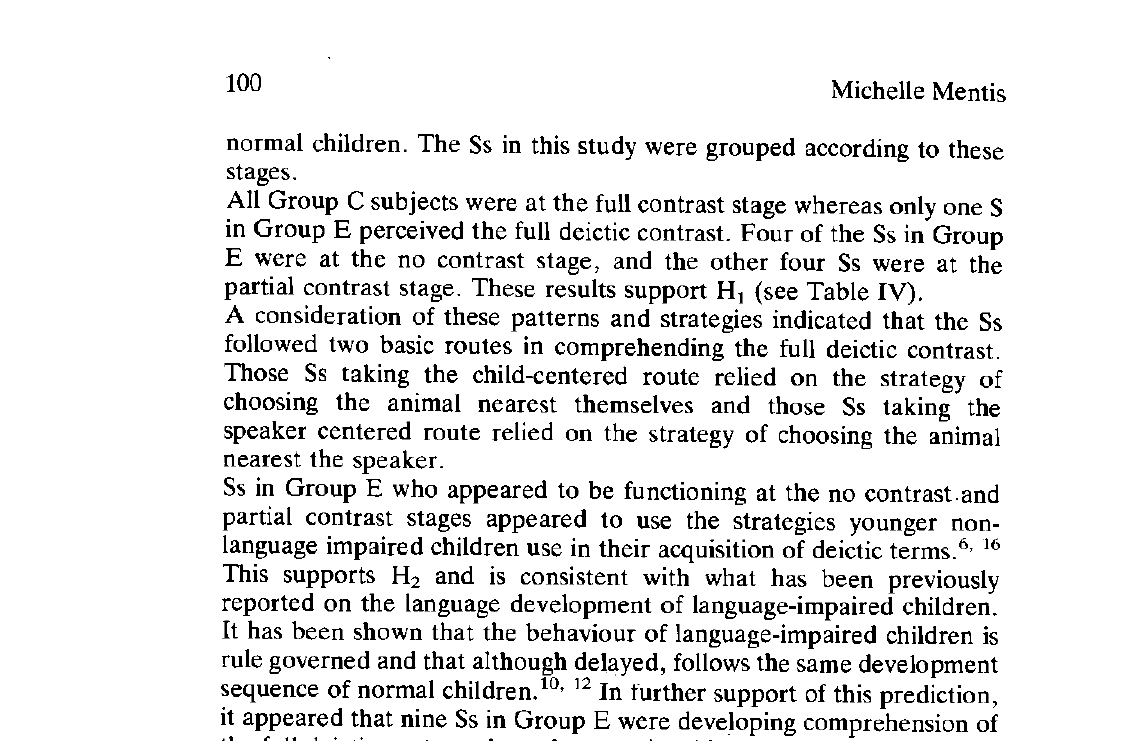
TABLE V: Mean Scores and Percentages of Correct responses Produced by each group (Task 2) Come Go Come Go Bring Take Bring